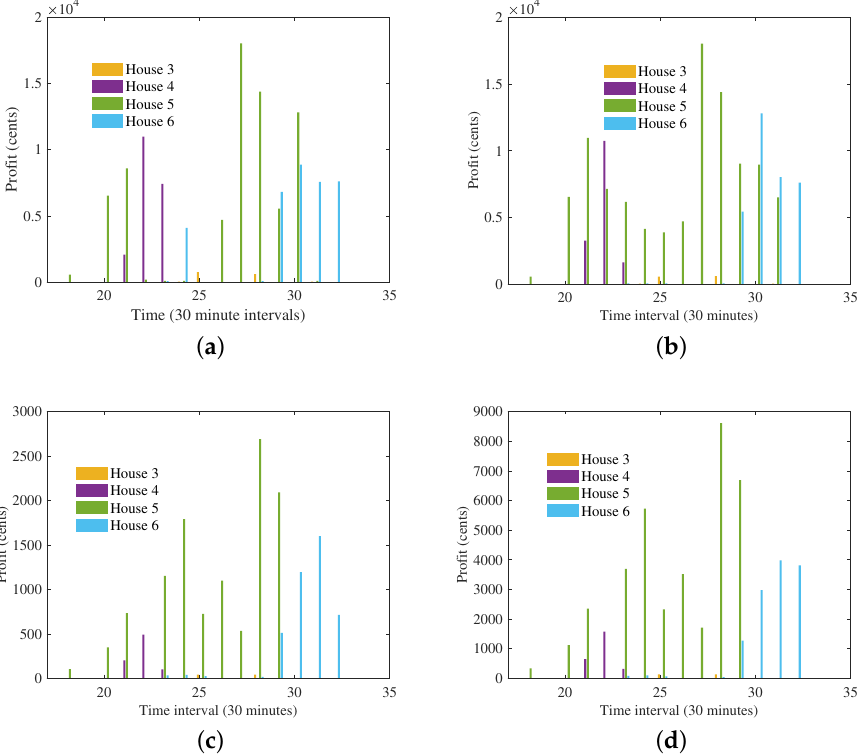
Figure 7. Hourly profit for the sellers in the microgrid considering different pricing structure. ( a ) Pricing as a function of energy; ( b ) Real time pricing; ( c ) Flat rate pricing; ( d ) Time of use